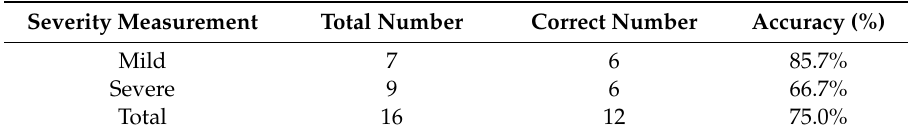
Table 5. Accuracy of severity measurement in CD